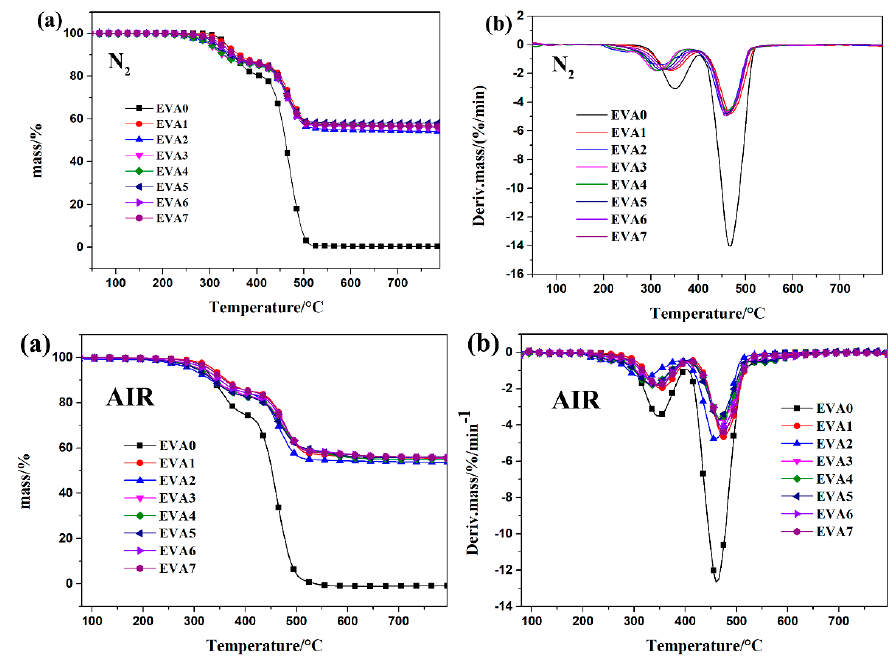
Figure 8. Thermal stability of neat EVA and the EVA composites under N 2 and air atmosphere. Table 6. TG data of ceramifiable EVA composites under nitrogen and air